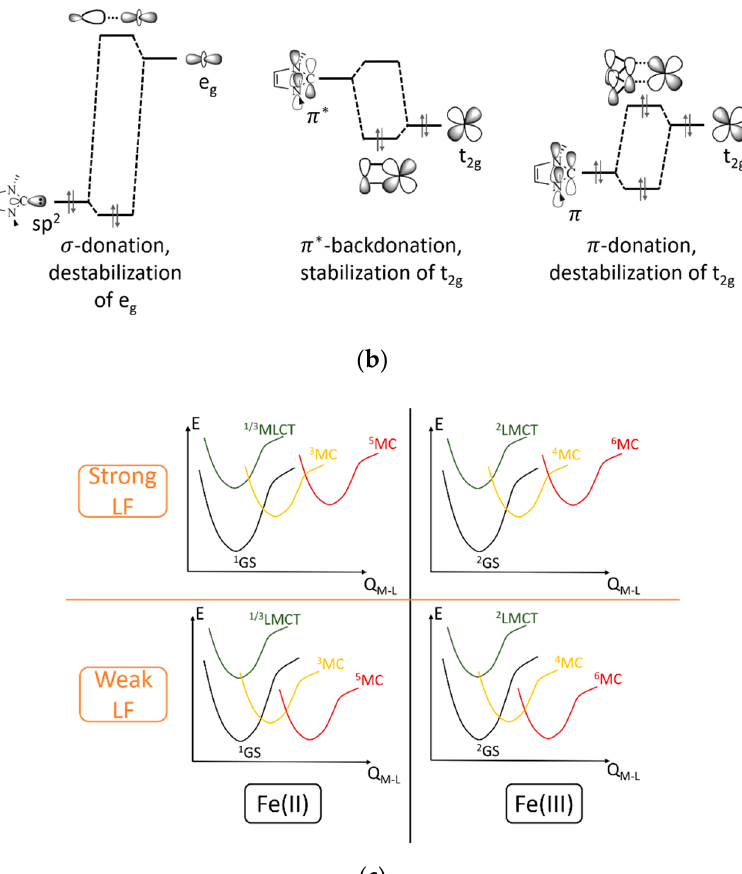
Figure 3. Schematic illustration of electronic structure of quasi-octahedral Fe(II) and Fe(III) NHC complexes. ( a ) Prototype metal-ligand bonding interactions and typical optical excitations in FeNHC complexes. Note that the ligand-to-metal charge transfer (LMCT) excitations to the t 2g levels are generally absent in Fe(II) complexes with a filled (t 2g ) 6 configuration on the metal center. ( b ) carbene-metal donation and backdonation interactions (illustrated under the assumption of a (t 2g ) 6 electronic configuration for a Fe(II) complex). ( c ) Fe(II) and Fe(III) prototype ground and excited state potential energy schemes in weak and strong ligand field